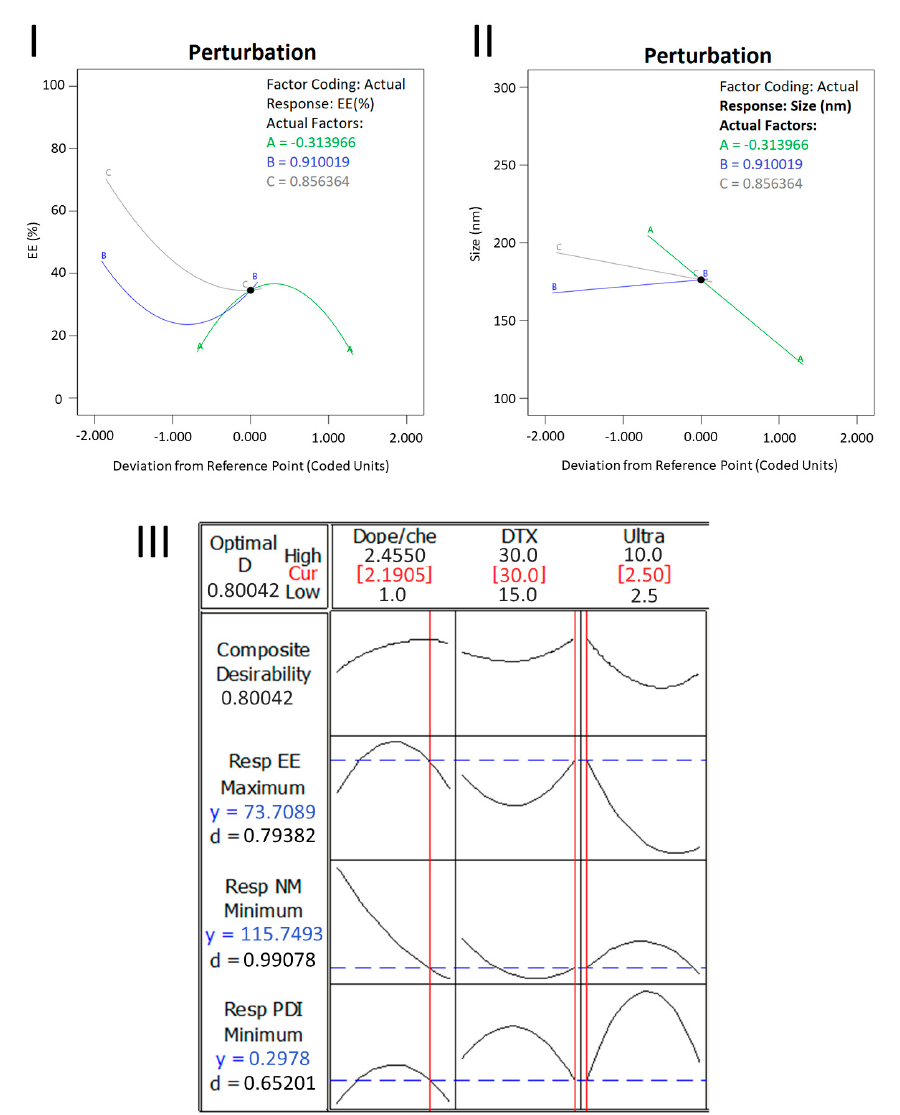
Figure 2. Perturbation plot and optimization graph. The perturbation plot ( I ) shows the effects of the variables DOPE/CHEMS ratio (green), docetaxel/lipid ratio (blue) and sonication time (gray) for encapsulation efficiency (EE%). Graph ( II ) shows the effects of the same variables on particle size (nm). Graph ( III ) presents the graphical optimization for the desired formulation.